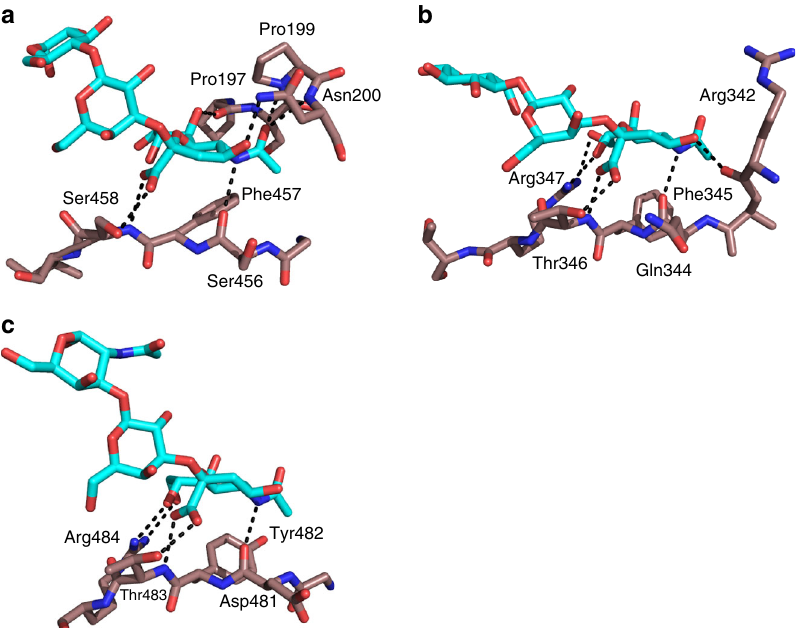
Fig. 3 Comparison of sialic binding sites in bacterial adhesins. Binding of the oligosaccharides neuraminic acid moiety to a adhesin P110 from M. genitalium and to the serine-rich repeat (SRR) adhesins from b SrpA 67 (PDB accession code 5IJ1), and c GspB 68 (PDB accession code 5IUC). The extended tripeptide X-Tyr/Phe – Ser/Thr (residues 456 – 458 in P110) appears to be a common binding motif for sialic acid. Carbon atoms for the oligosaccharides are represented in light blue, while for amino acid residues are represented in brown. Nitrogen and oxygen atoms are depicted in dark blue and red,